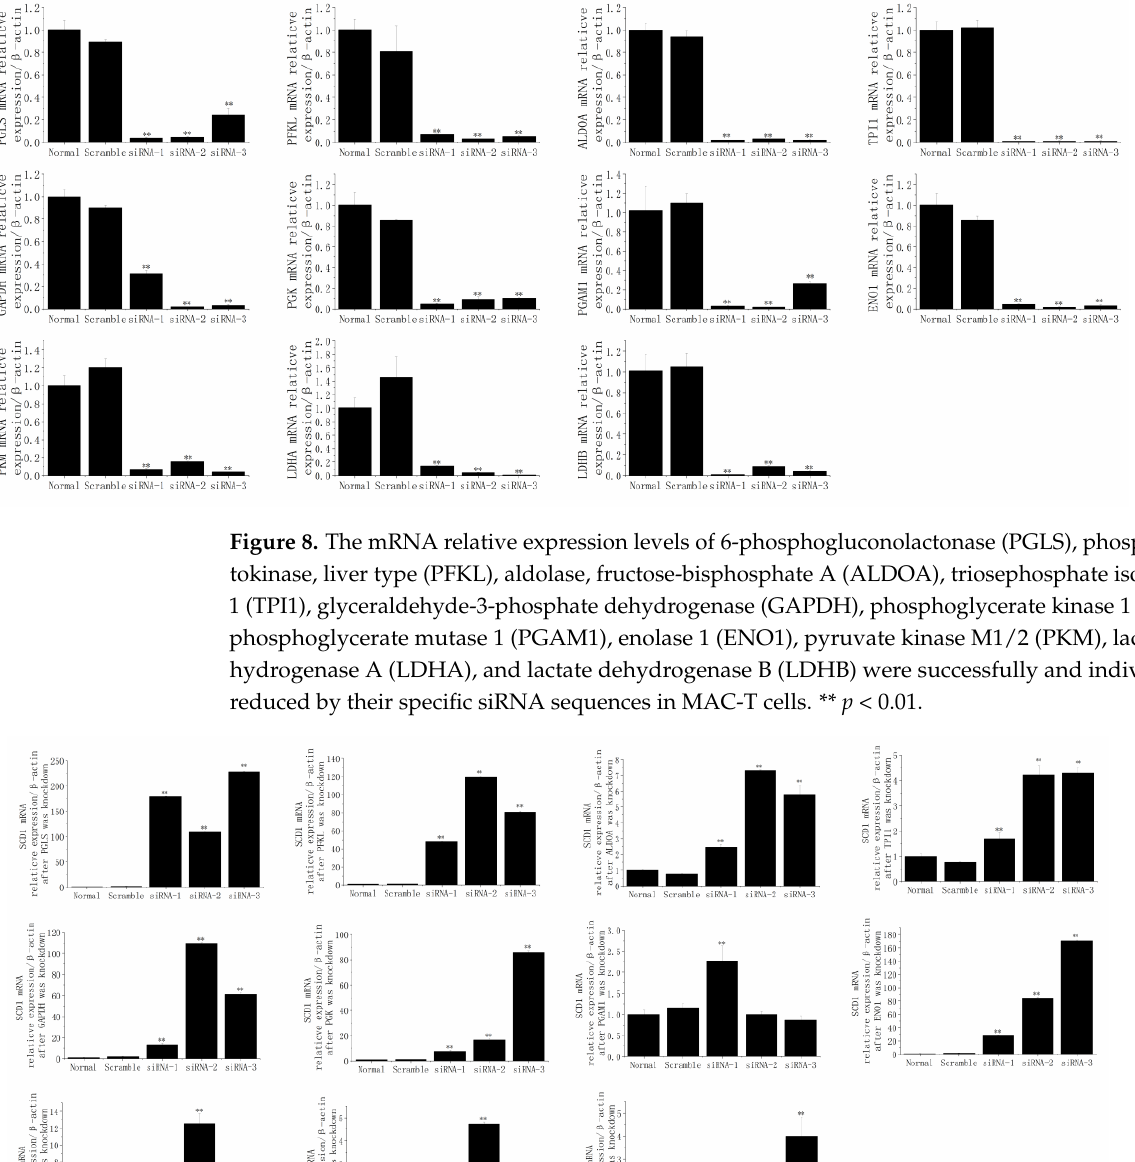
Figure 10. The SCD1-dependent gene network of c9, t11-CLA biosynthesis from the perspective of energy metabolism. The green color protein indicates that they were verified to have negative rela- tionships with SCD1.